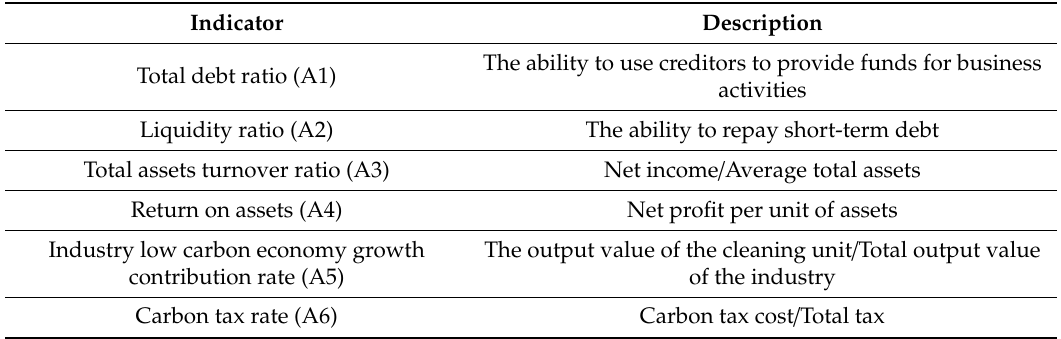
Table 1. Economic development indicators.